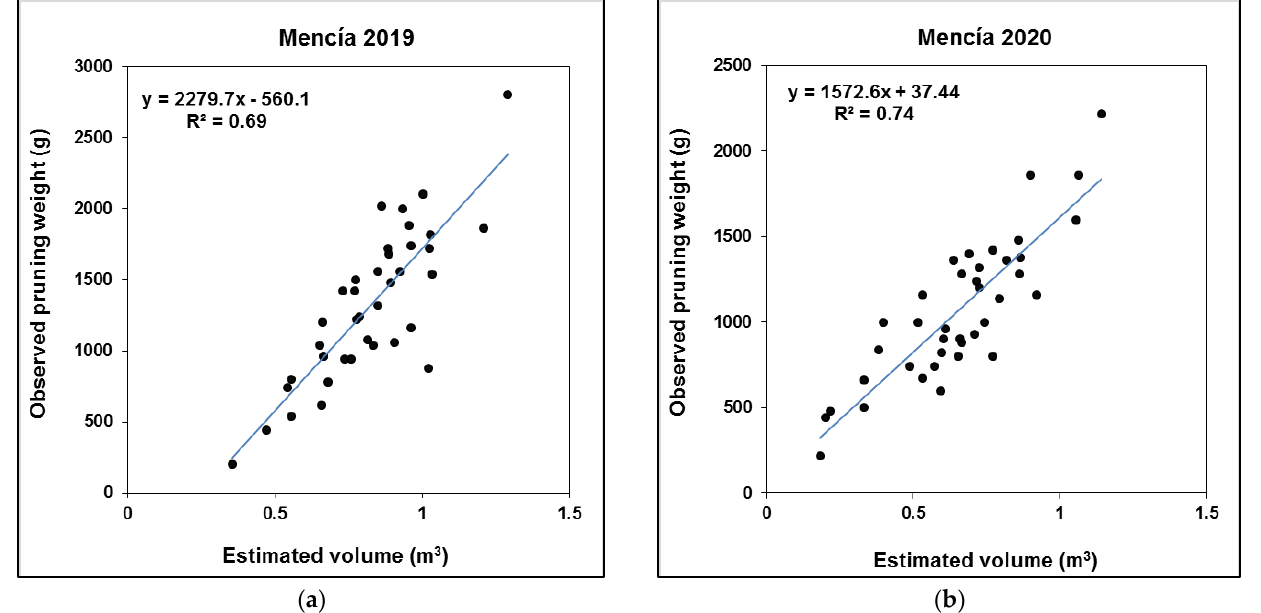
Figure 5. Observed pruning weight vs. estimated volume and respective regression lines for: ( a ) Mencía 2019; and ( b ) Mencía 2020 (solid line = linear regression).